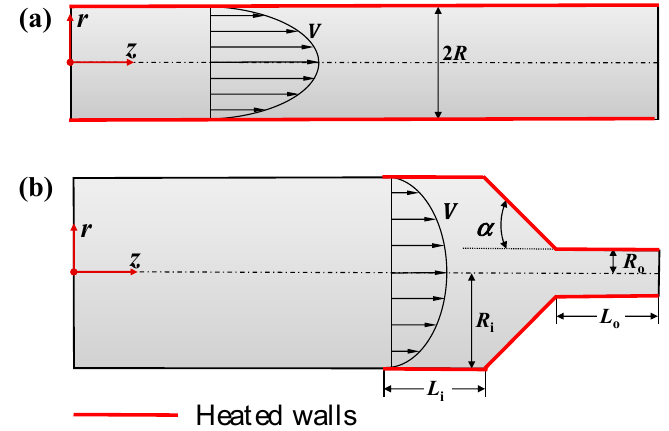
Figure 2. Geometries of ( a ) the straight pipe and ( b ) the tapered injector. R i and R o are the radii of the inlet and the outlet cross-sections, respectively. The red color indicates heated walls.